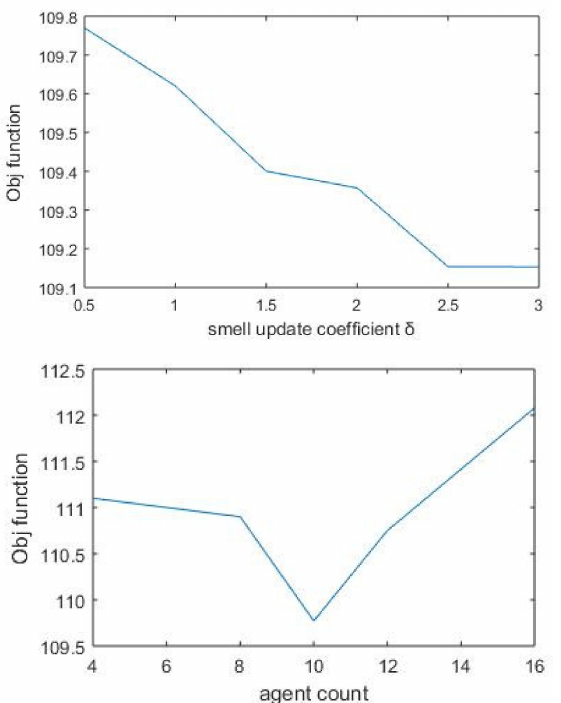
Figure 4. Objective function based on varying values of parameter δ . The smell update coefficient takes the value 0.5 corresponding to the maximum objective function. Agent_count represents the number of agents used by the algorithm for finding separate paths. After performing multiple runs, final value is taken as